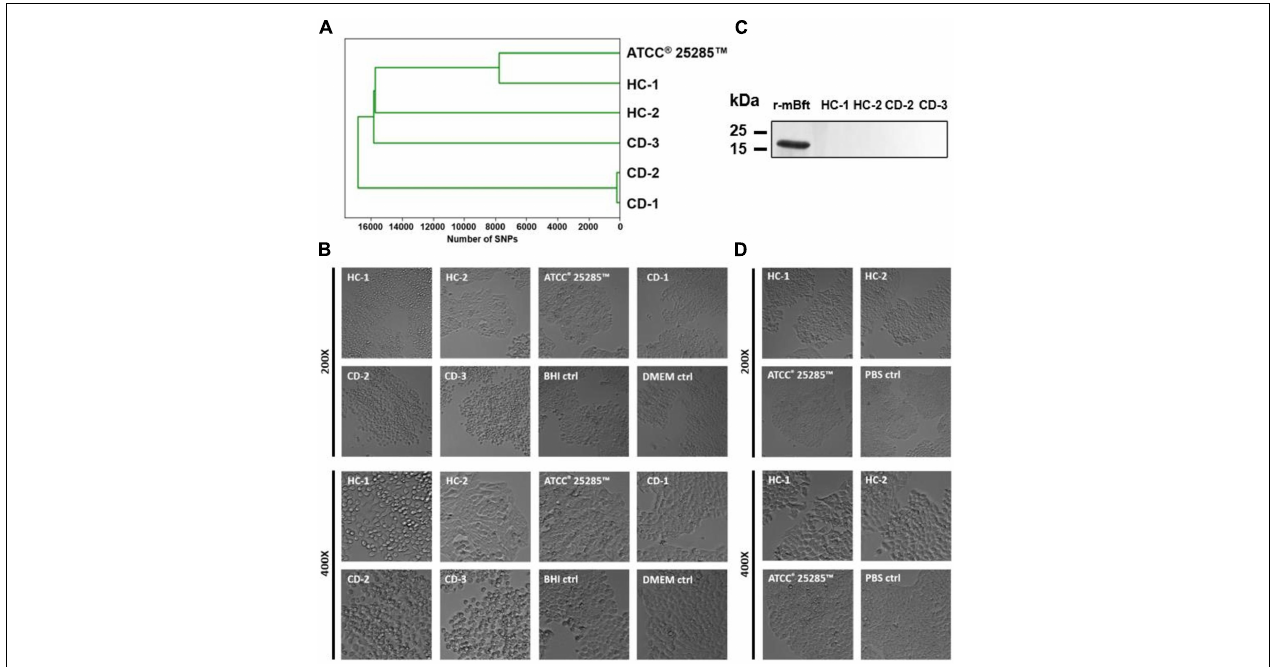
FIGURE 2 | Characteristics of cultured B. fragilis strains. (A) Based on whole genome sequencing, pairwise genetic distance revealed 160 SNPs between CD-1 and CD-2, whereas the median distance was 16960 SNPs. (B) Cell rounding of subconfluent HT-29 cells could be detected in the supernatants of all bft -positive strains (HC-1, CD-2, CD-3). (C) Mature Bft could not be detected in the supernatant of bft -positive strains when compared to 200 ng of recombinant mature Bft (r-mBFT). (D) Cell rounding of subconfluent HT-29 cells could not be detected in response to bft- positive strain-derived